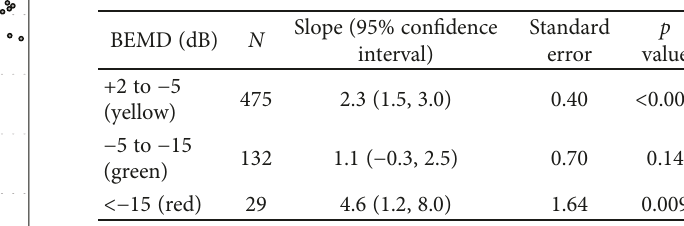
Table 1: Relationship between decline in NEI VFQ-25 score for piecewise regression analysis for each 1 dB decline in BEMD